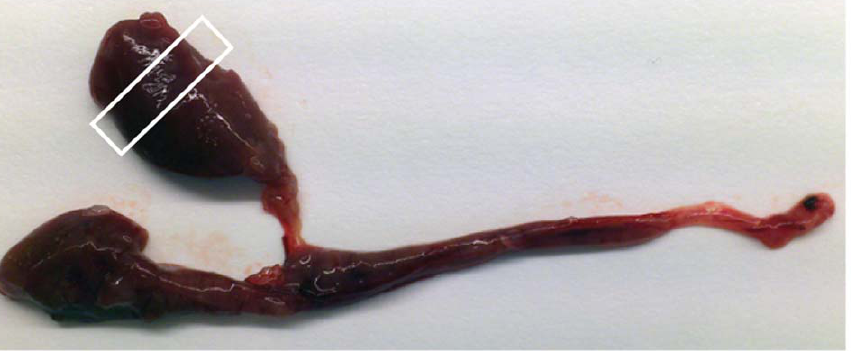
Figure 1. Lumpsucker kidney used for isolation of leucocytes. Dissected kidney where the section used for isolation of leucocytes from the left cranial lobe is